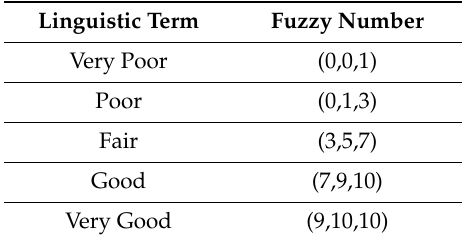
Table 2. Linguistic variables and fuzzy